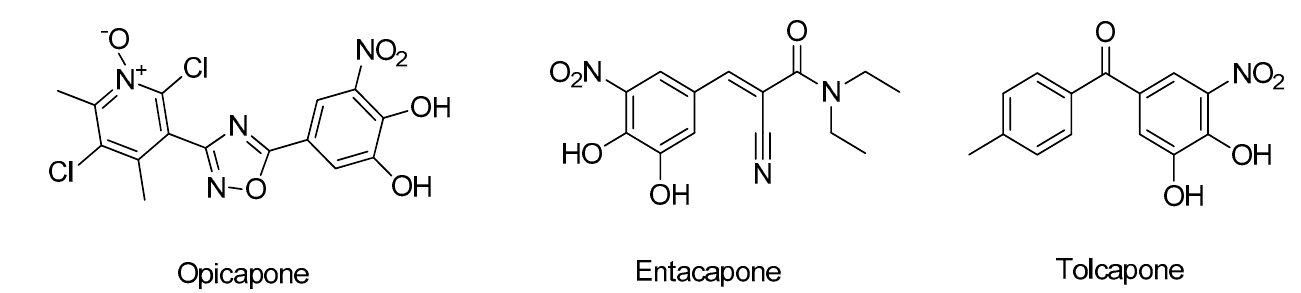
Figure 22. Structures of the clinically approved COMT inhibitors.